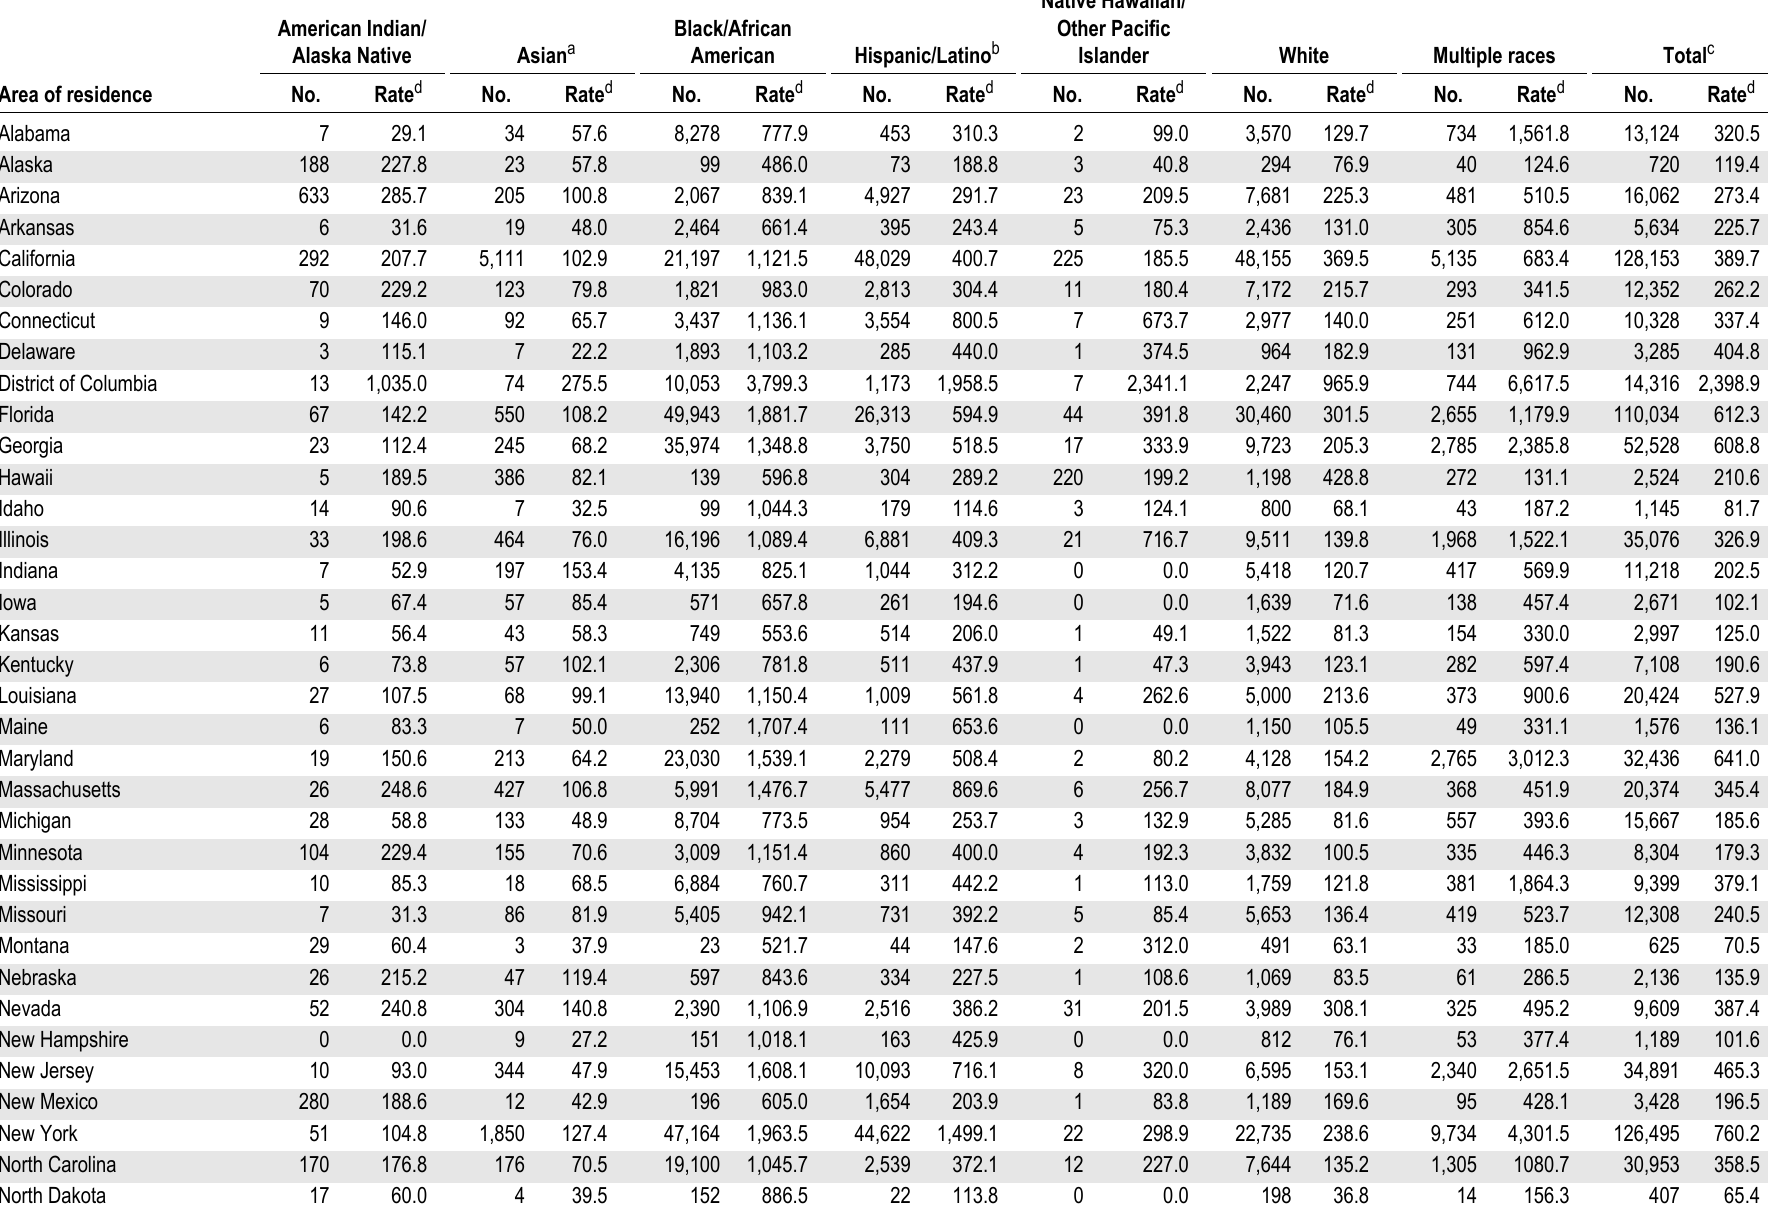
Table 28. Adults and adolescents living with diagnosed HIV infection, by race/ethnicity and area of residence, year-end 2017—United States and 6 dependent areas